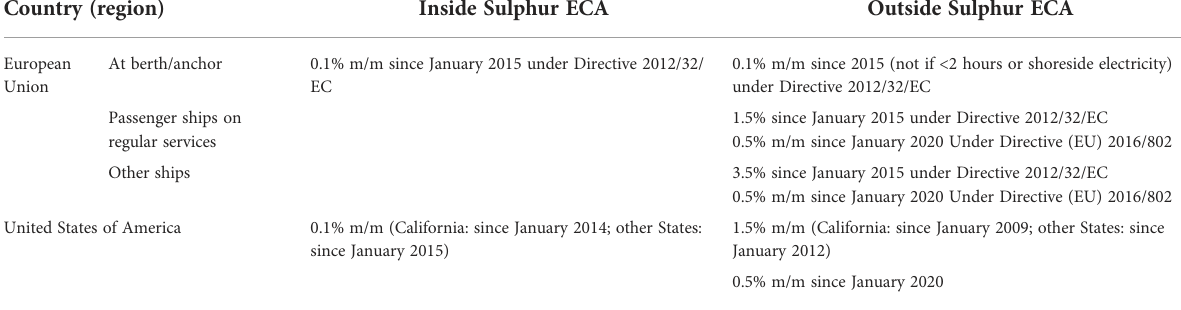
TABLE 1 Requirements and implementation date of marine fuel sulfur regulations in EU and USA. Country (region) Inside Sulphur ECA European At Union